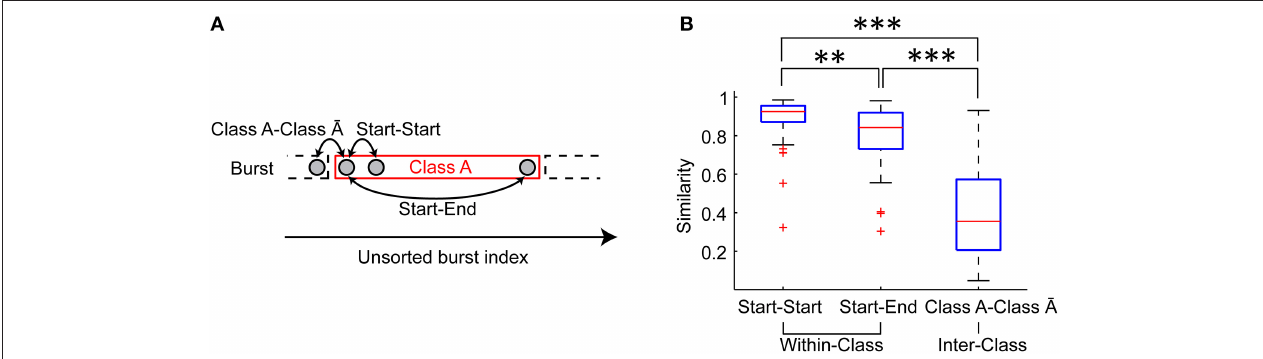
FIGURE 6 | Variation of spatiotemporal patterns during a period of the same class burst. (A) Similarity of the first two bursts in a given period (Start-Start pair), that of the burst pair at the start and end of a given period (Start-End pair) and that of the successive burst pair at the transition of the period (Class A-Class ¯A pair) were evaluated. (B) Similarity of Start-Start pair, Start-End pair and Class A-Class ¯A pair. The red lines indicate the median of the similarities. The blue boxes are ranges from the 25th percentiles to the 75th percentiles. The whiskers are the ranges of the all similarity excluding outliers (the red crosses). Wilcoxon signed-rank test. ** p < 0.01 . *** p < 0.001 .